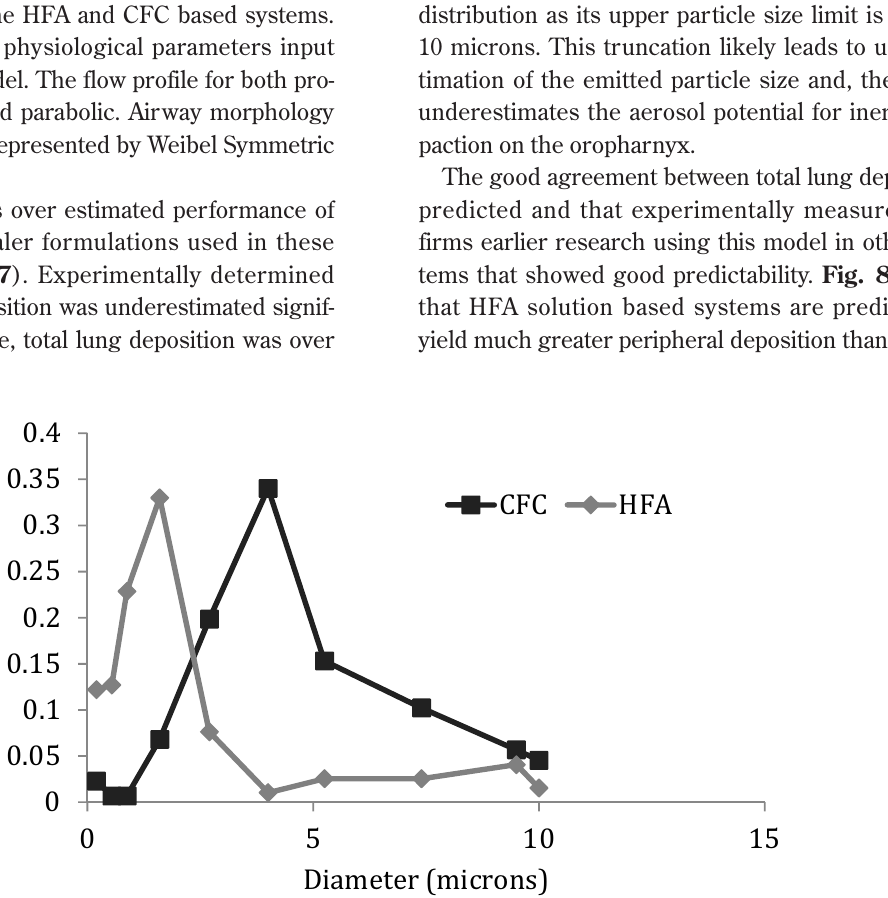
Fig. 6 Particle size distributions used as input data for the in silico model predictions of lung deposition.